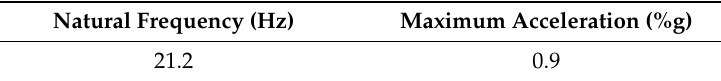
Table 13. Natural frequency and maximum